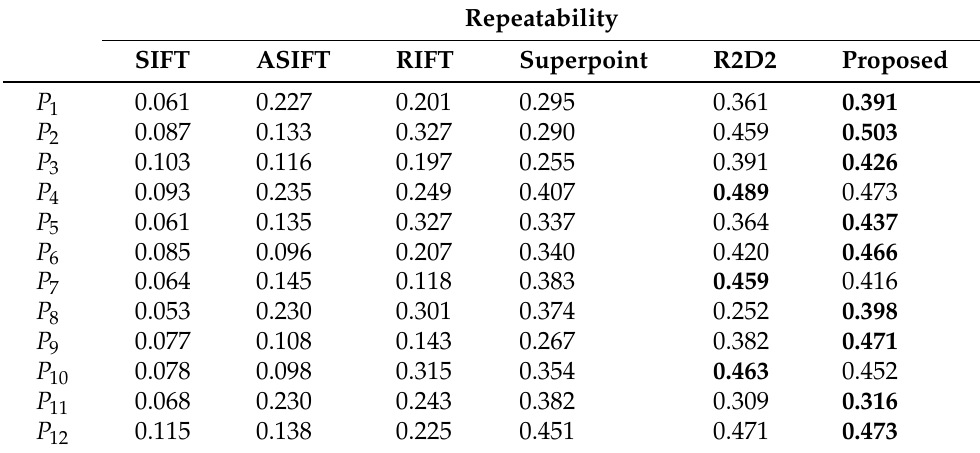
Table 3. The repeatability of keypoints on P 1 . . . P 12